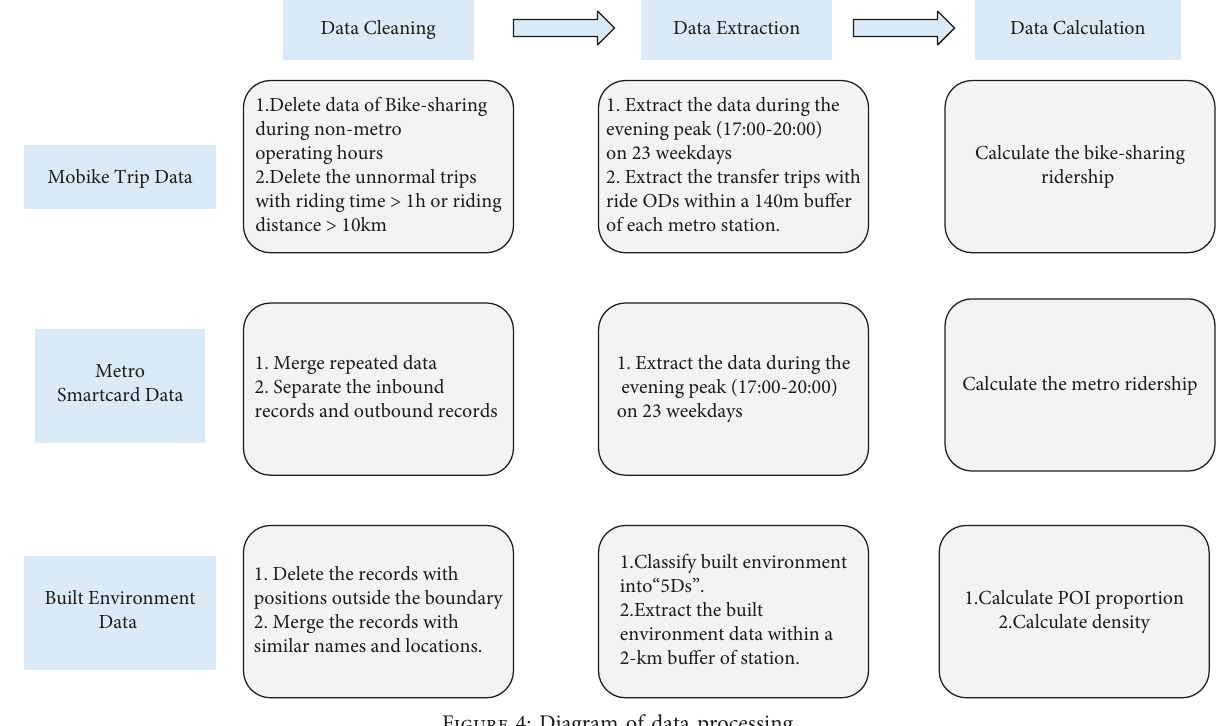
Figure 4: Diagram of data